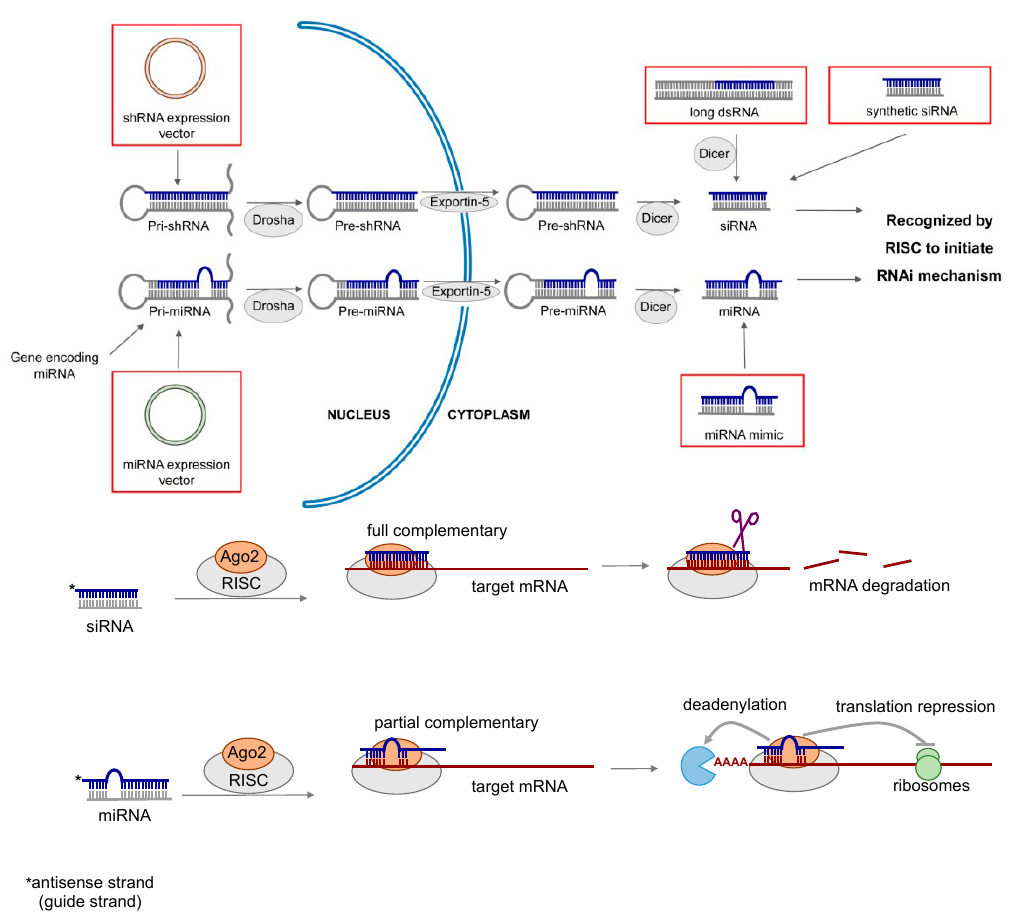
Figure 1. Mechanism of RNA interference (RNAi) induced gene silencing. Short interfering RNA (siRNA) can be produced inside the cells from double stranded RNA (dsRNA) or expressed from short hairpin RNA (shRNA) vector, or chemically synthesized in the laboratory. Its gene silencing effect is dependent upon fully complementary binding of the target messenger RNA (mRNA). MicroRNA (miRNA) is a naturally occurring molecule. It can also be expressed from miRNA vector or chemically synthesized (miRNA mimic). miRNA mediates gene silencing via the partial complementary binding of the target mRNAs.